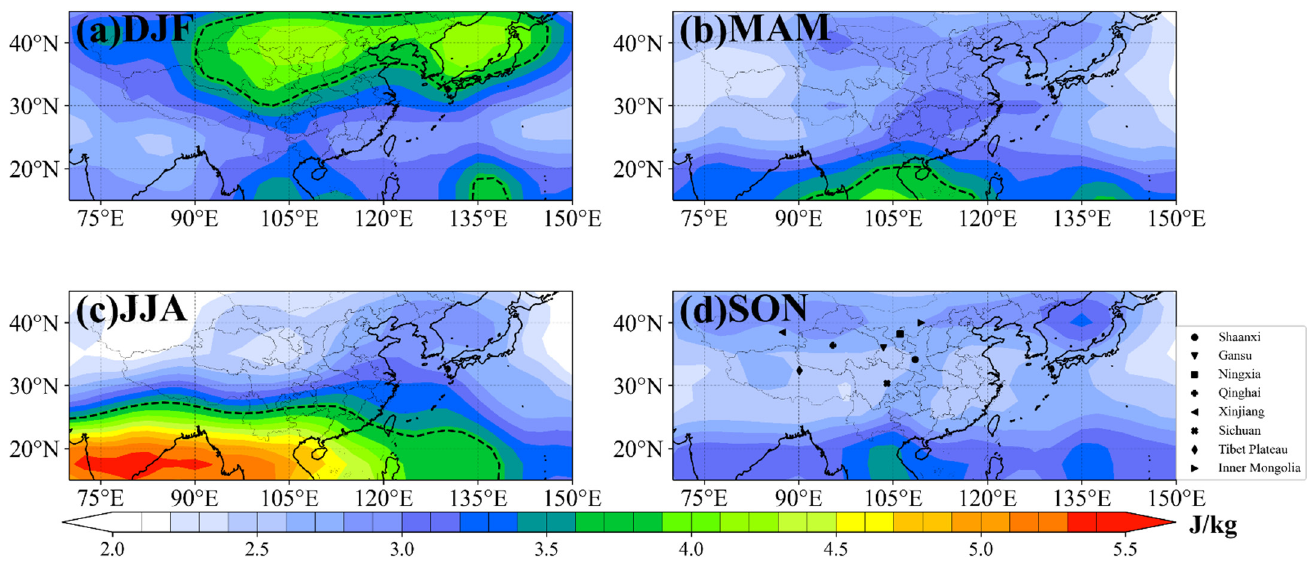
Figure 3. Seasonal mean distribution of Ep in the lower stratosphere. ( a ) DJF, ( b ) MAM, ( c ) JJA, and ( d ) SON, where the dotted line is the sum of the mean and standard deviation of the four seasons Ep.